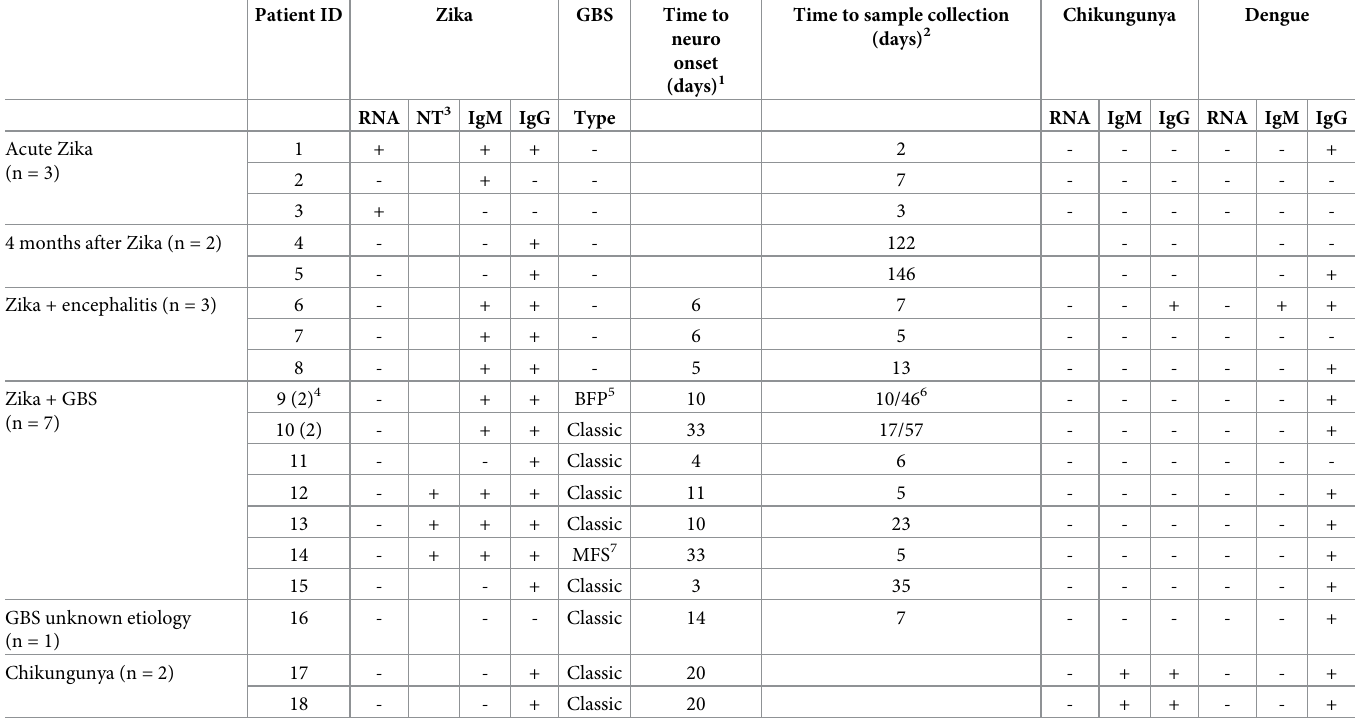
Table 1. Patient diagnosis and detection of Zika RNA (by RT-PCR) and arbovirus IgM and IgG by ELISA. Patient